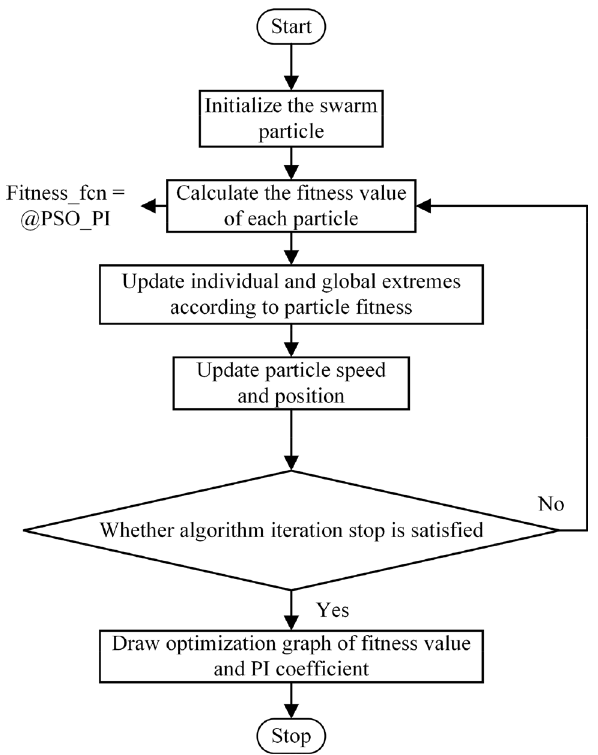
Fig. 6 PF-PI controller of BLDC motor algorithm flow chart